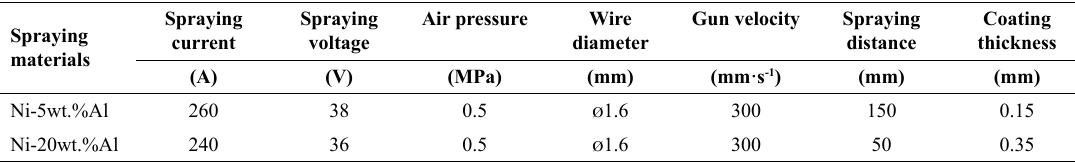
Table 3. Processing parameters of arc spraying.